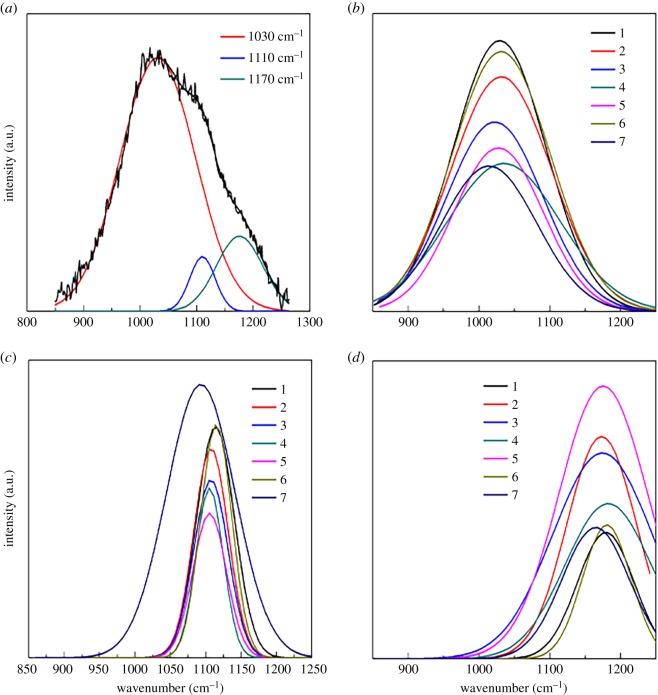
Gaussian fit of Raman peaks: (a) 850 ∼ 1250 cm−1; (b) around 1030 cm−1; (c) around 1100 cm−1; and (d) around 1170 cm−1.